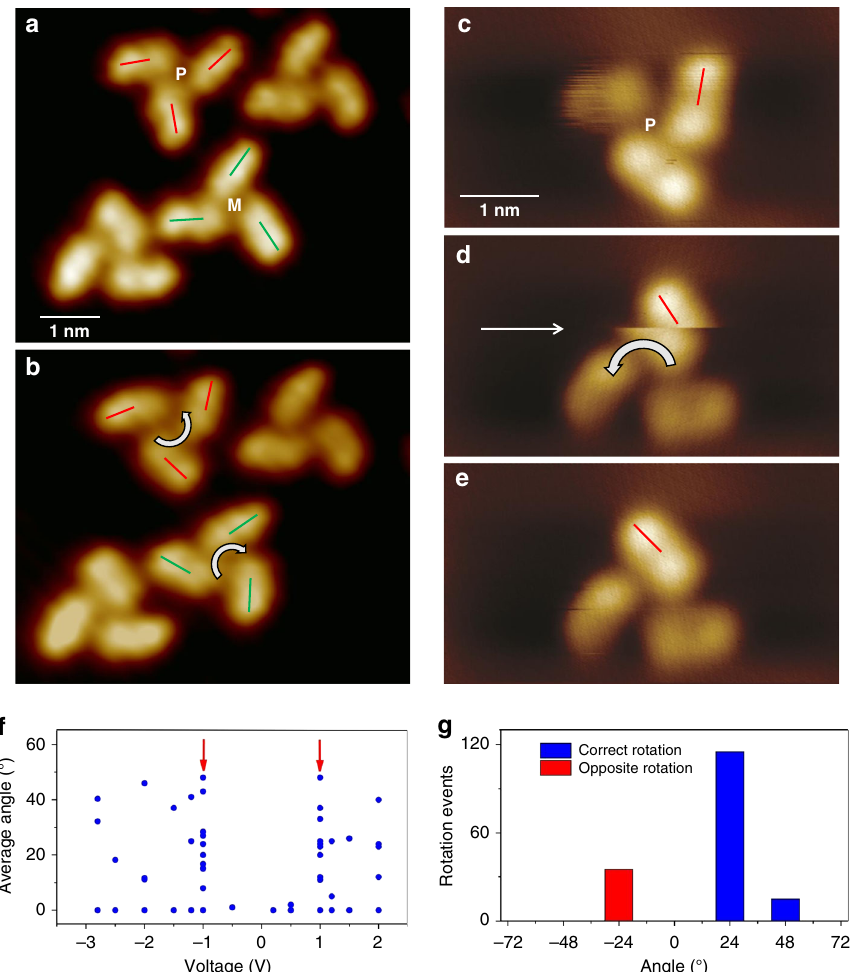
Fig. 3 Unidirectional rotation. a STM image of molecular propellers on Au(111) surface where the respective chirality of two of the propellers are indicated [Imaging parameters: V t = − 0.5 V, I t = 17 pA]. b When the same area was scanned with − 1 V, the ‘ P ’ and ‘ M ’ propellers are rotated to anticlockwise and clockwise directions, respectively [Imaging parameters: V t = − 1.0 V, I t = 17 pA]. c An STM image of a ‘ P ’ propeller. d During a consecutive imaging, the propeller is rotated causing a sudden change in the image contrast (indicated with an arrow). e The fi nal position of the propeller after the rotations [Imaging parameters: V t = − 1.0 V, I t = 50 pA]. f Average rotation angle as a function of bias. The arrows indicate the threshold bias at ±1 V. g A statistical plot of the